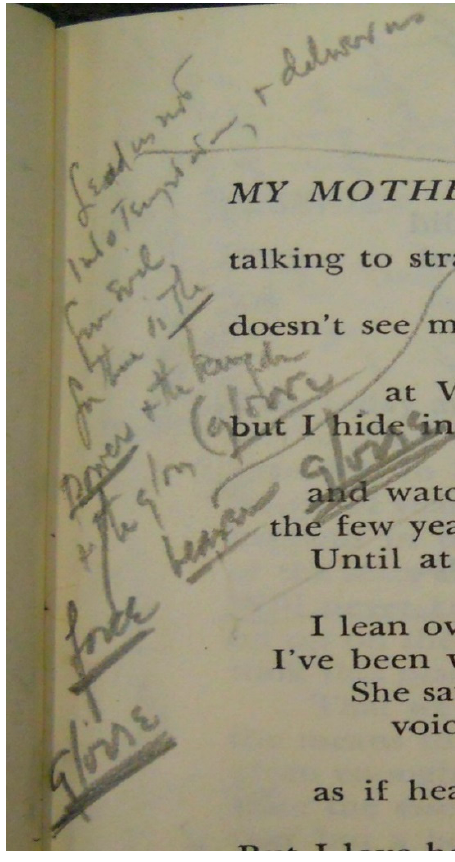
Figure 6. Page 33 of “Manuscript. Written on ‘Ace of Pentacles’ by John Wieners”, box 24, folder 1147, CORC.